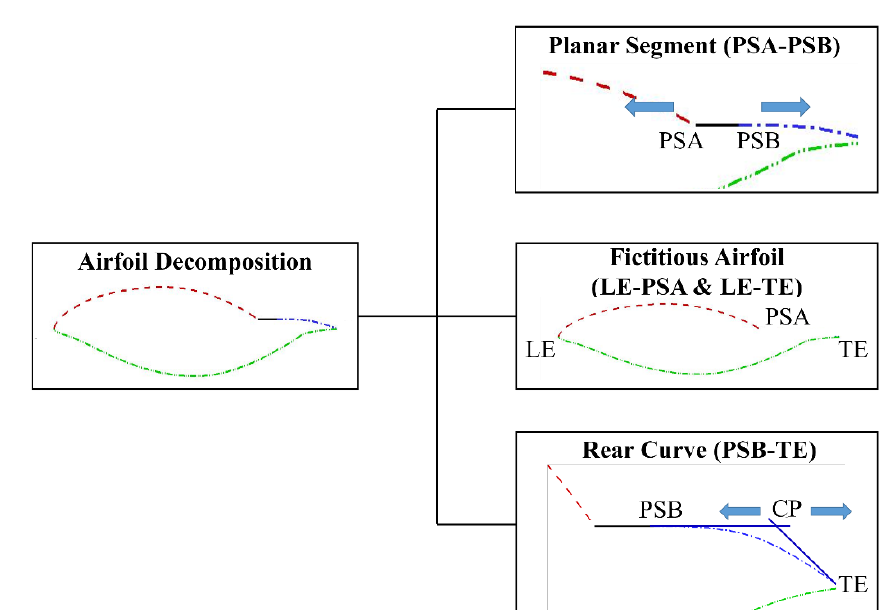
Figure 4 . Sketch of the developed sectional airfoil parametric method.